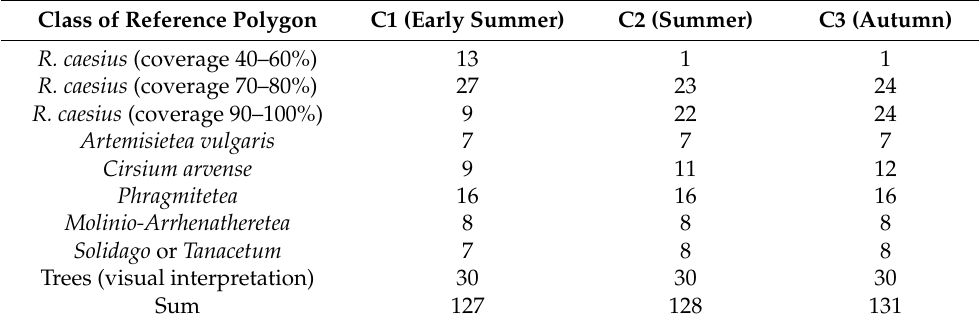
Table 2. The number of reference polygons acquired during the three field